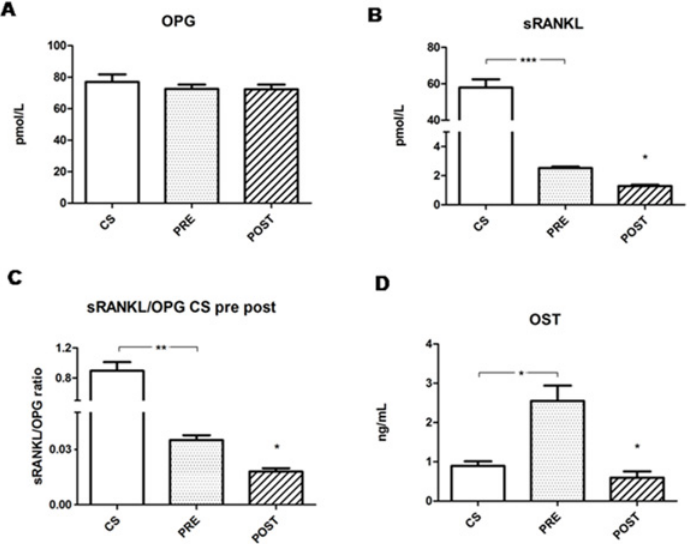
Figure 7. Levels of OPG, sRANKL, sRANKL/OPG, osteocalcin and collagen type I in response to serum from uremic patients after a single hemodialysis session. OPG levels (panel A), sRANKL (panel B) and their relevant ratio (panel C), osteocalcin (OST, panel D) were measured, in the medium, during osteogenic differentiation of hMSC grown in the presence of uremic serum from the same patients before (PRE) and after hemodialysis (POST). Results from control serum (CS) were added for comparison. * p <